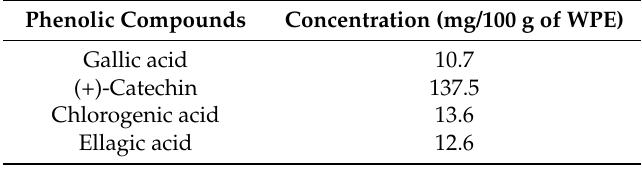
Figure 1. Representative HPLC chromatograms of phenolic bioactive compounds in walnut phenolic extract WPE. WPE was prepared from whole walnuts and its phenolic bioactive compounds, including gallic acid, (+)-catechin, chlorogenic acid, and ellagic, acid were detected by HPLC. WPE; walnut phenolic extract. Table 2. Quantitative determination of HPLC analysis on phenolic compounds present in phenol extract of walnut (WPE).